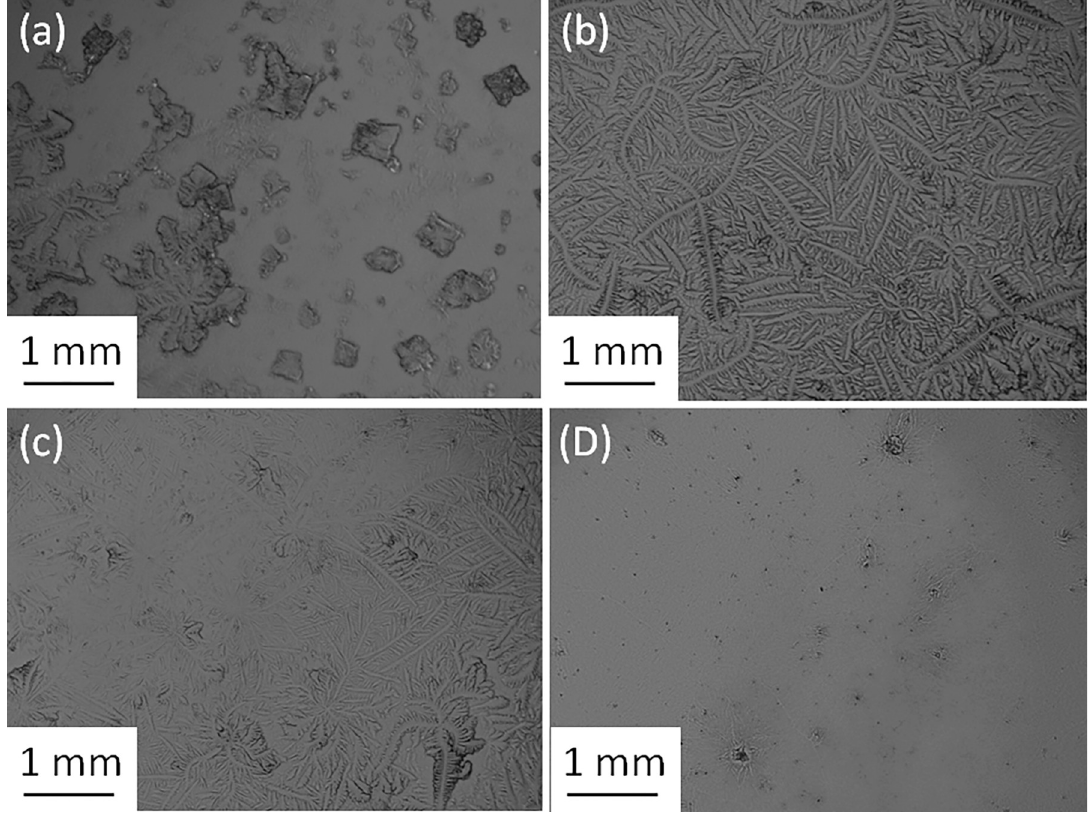
Fig 1. (a) Pure tears from subject 9, (b) pure tears + NaCl (20 mg, 1:3), (c) pure tears + KCl (20 mg, 1:5), and (d) pure tears + KCl (30 mg, 1:5).